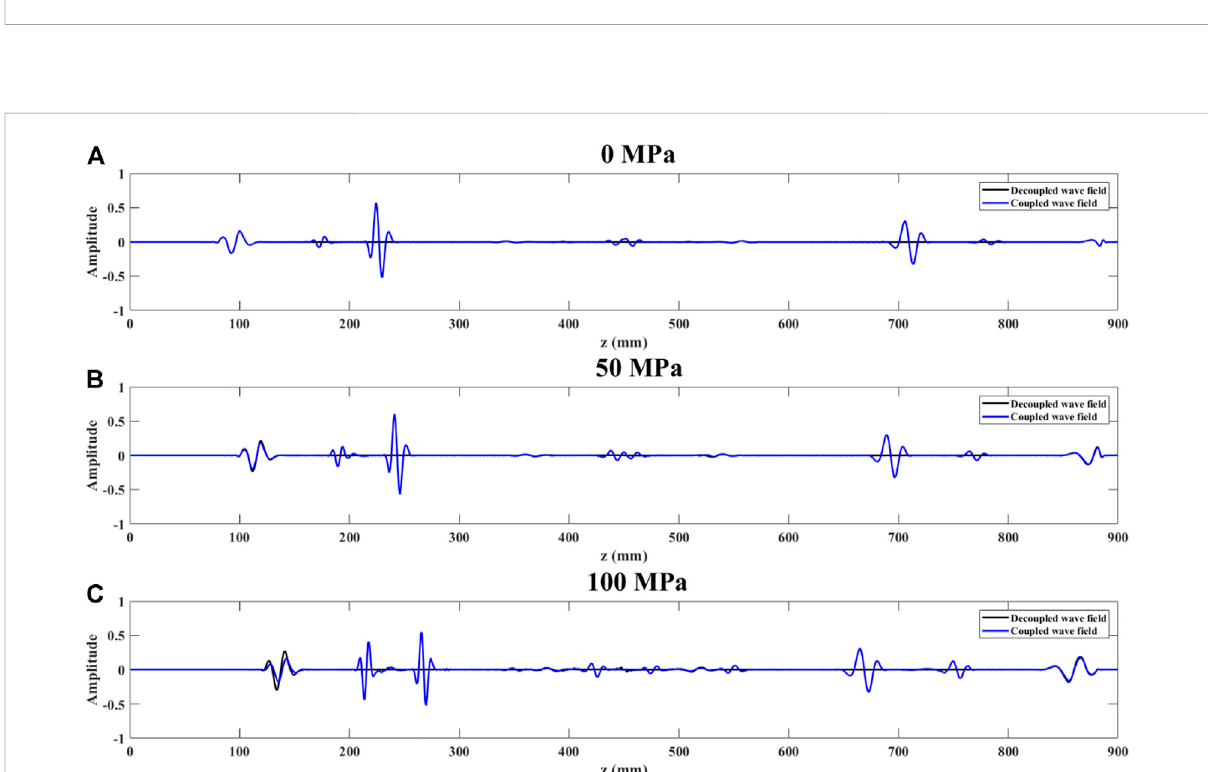
FIGURE 23 Records of x = 300 mm in snapshots above for various uniaxial stresses ( (A) : 0 MPa; (B) : 50 MPa; (C) : 100 MPa). (Blue dotted line is a record of coupled wave fi eld; Black line is a record of decoupled P-wave fi